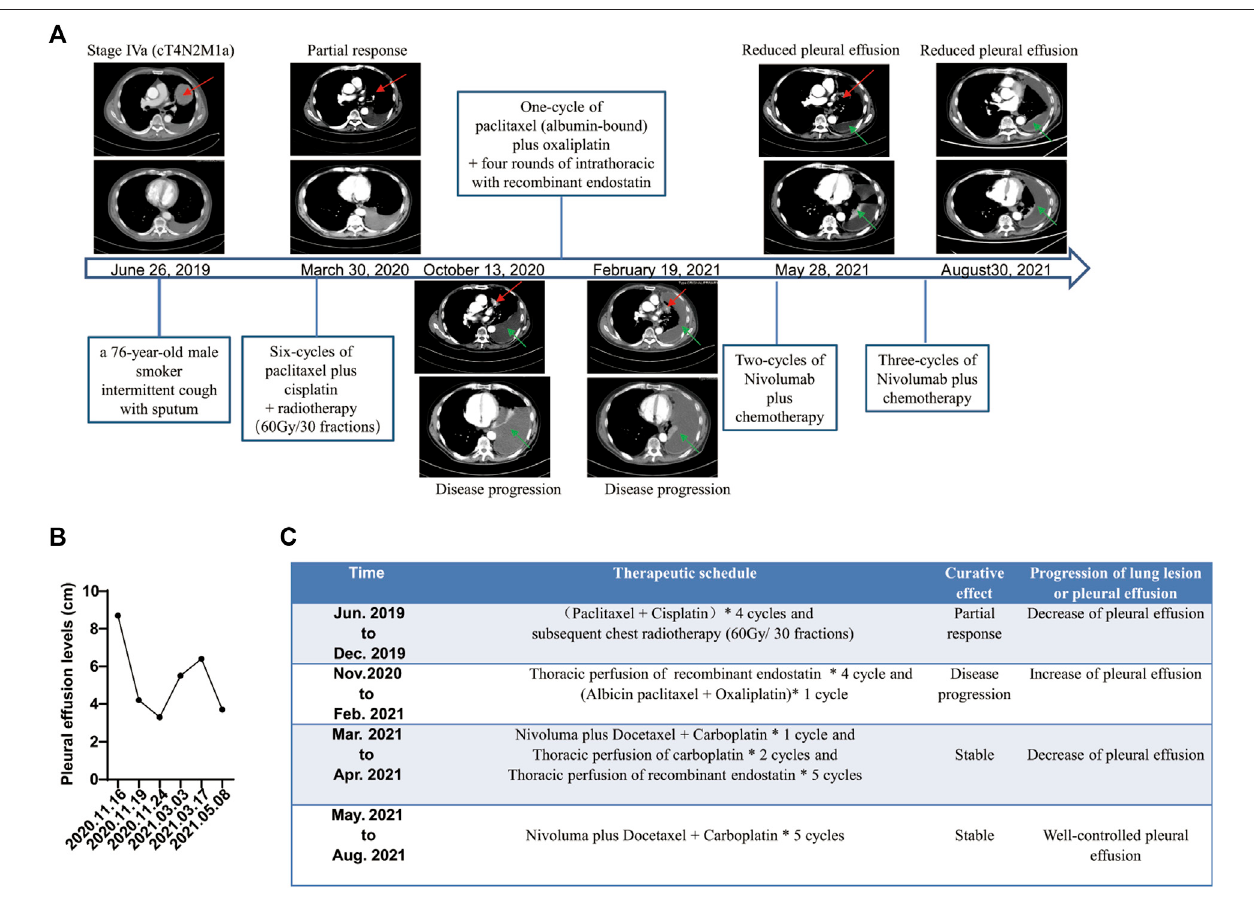
FIGURE2| Summaryoftreatmentscheduleandassociatedtherapeuticeffects. (A) Computedtomography(CT)fromJune26,2019,showsalesionintheleftlung and enlarged left mediastinal and hilar lymph nodes (red arrows). CT from March 30, 2020, shows partial response after six cycles of paclitaxel plus cisplatin chemotherapyandsubsequentradiotherapy(redarrows).CTfromOctober13,2020showsprogressivespreadofthetumorwithinthechestassociatedwithleftpleural effusion(greenarrows).CTfromFebruary19,2021,showsincreasedpleuraleffusionafteronecycleofsecond-linechemotherapy(greenarrows).CTfromMay28, 2021,toAugust 30,2021, shows well-controlled pleural effusion after fi vecourses ofnivolumab plus chemotherapyand four rounds ofintrathoracic chemotherapy with recombinantendostatinfollowedbytworoundsofthatwithrecombinantendostatinpluscarboplatin(greenarrows). (B) Pleuraleffusionlevelsbeforeandaftertreatment with nivolumab plus chemotherapy by B-mode ultrasound. (C) Treatment course and results.